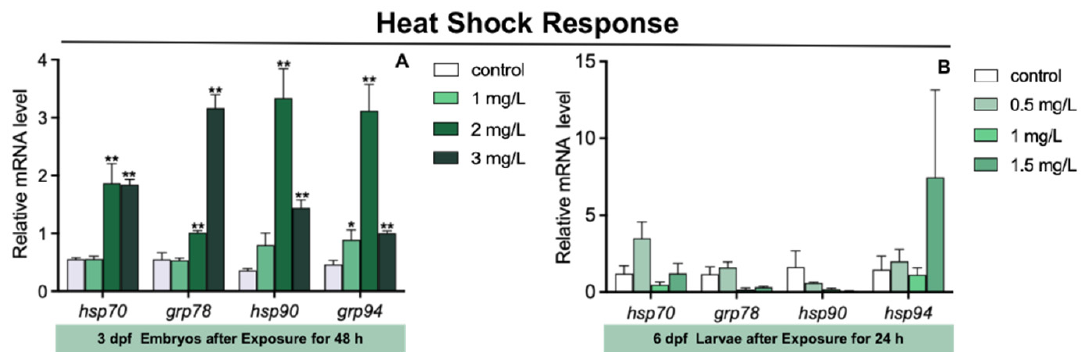
Figure 4. The expression of heat shock response genes (including hsp70 , grp78 , hsp90 , and grp94 ) in zebrafish. ( A ) For 3 dpf zebrafish embryos, the expression of hsp70 , grp78 , hsp90 , and grp94 after triflumizole exposure for 48 h. ( B ) For 6 dpf zebrafish larvae, the expression of hsp70 , grp78 , hsp90 , and grp94 after triflumizole exposure for 48 h. Data are expressed as the mean of three replicates ± standard error (SEM). Asterisks denote significant differences between the control group and TFZ groups (determined by Dunnett post hoc comparison, * p < 0.05, ** p < 0.01). hsp70 : heat shock protein 70; grp78 : glucose-regulated protein 78; hsp90 : heat shock protein 90; grp94 : glucose-regulated protein 94.